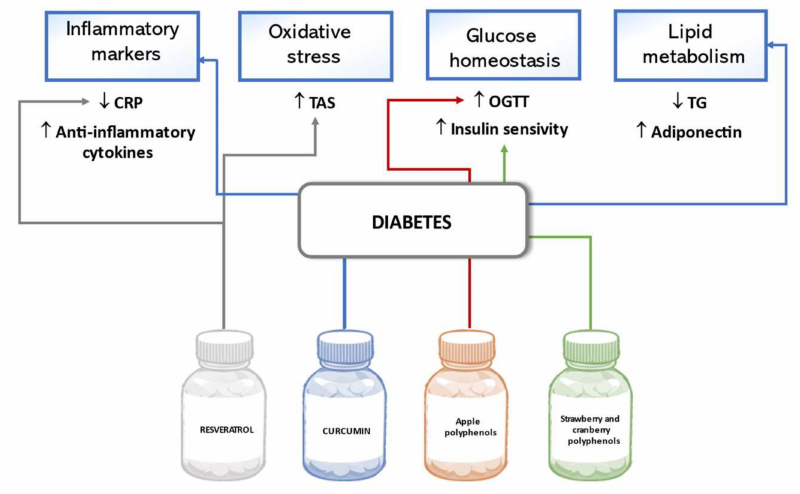
Figure 5. Effects of polyphenols on diabetes in human